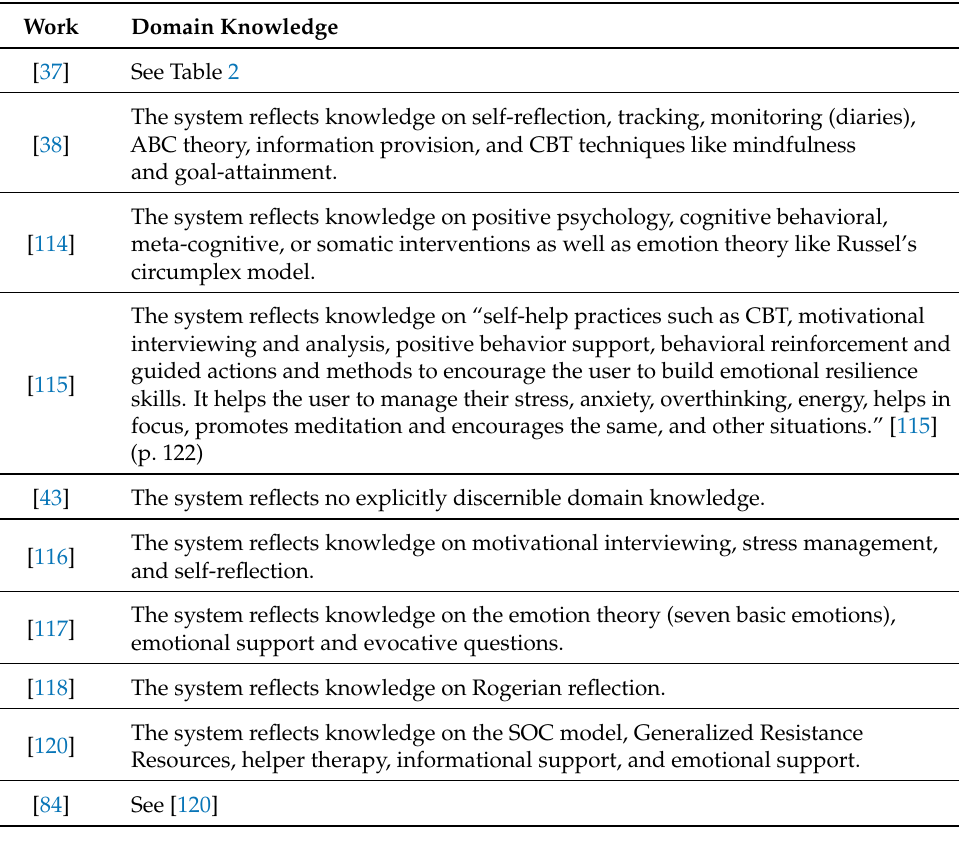
Table 6. Answering RQ5. What domain knowledge is used to achieve ABC for SAD?